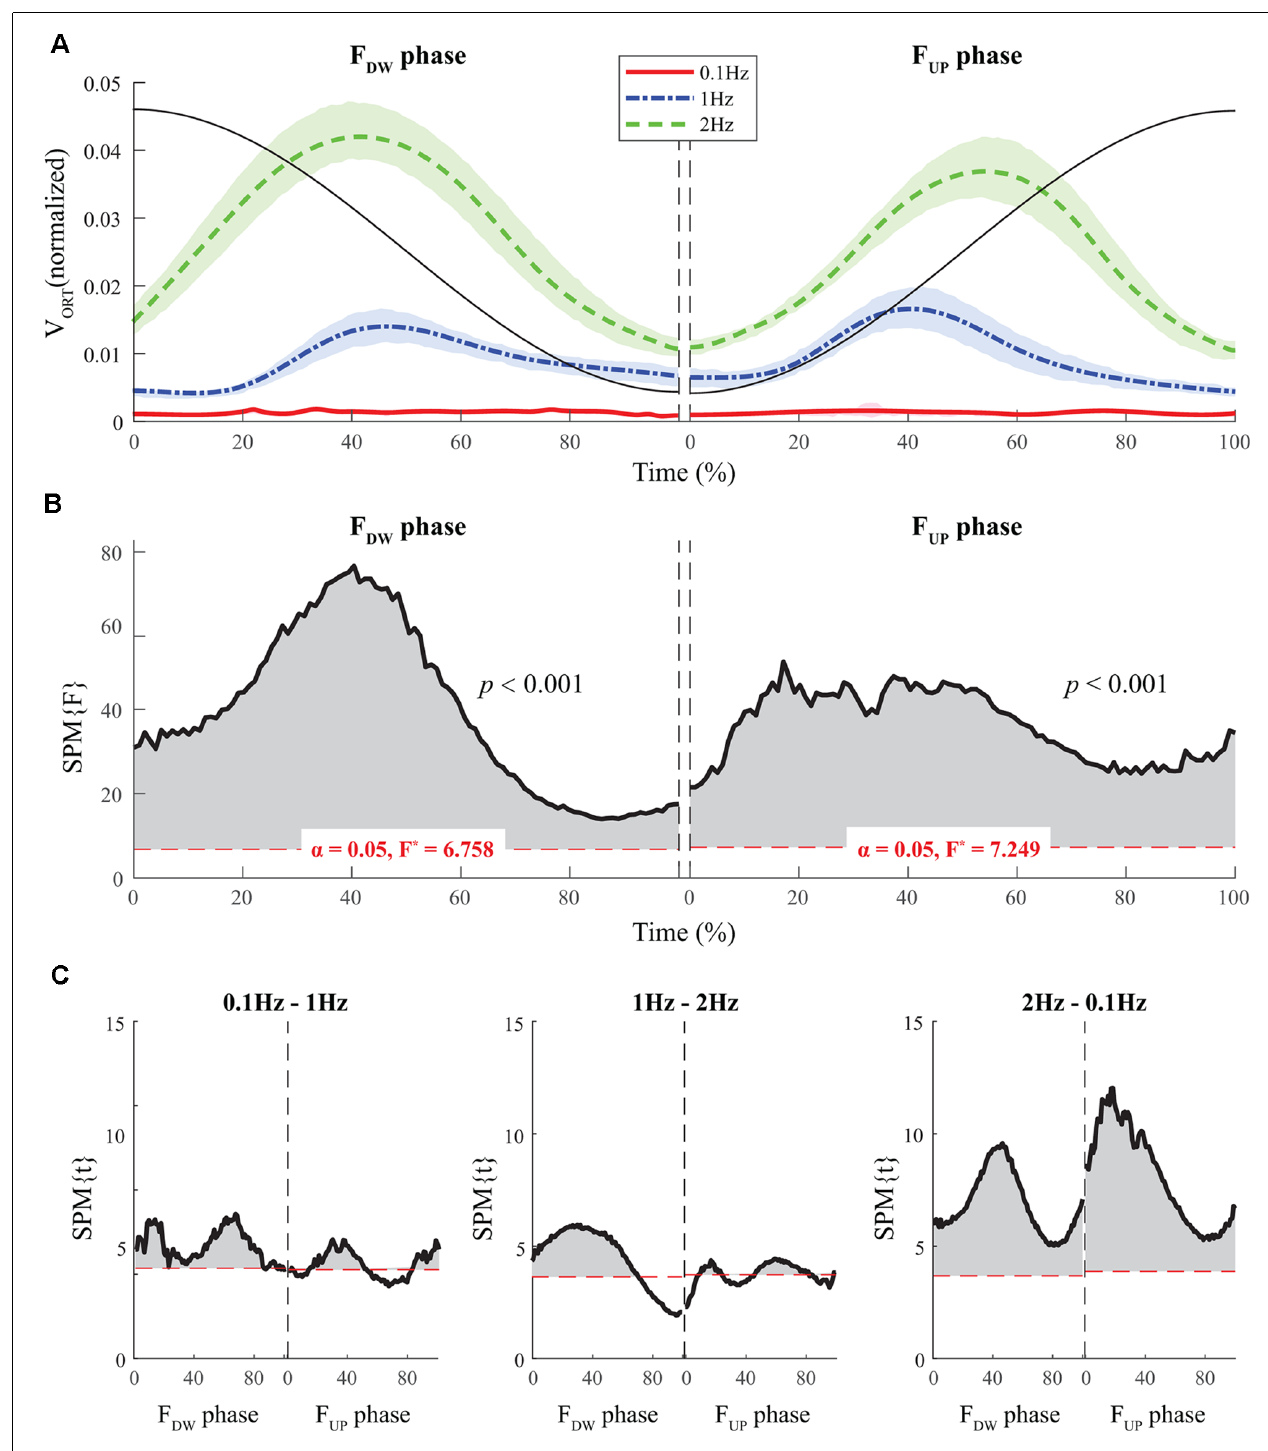
FIGURE 5 | The sample data of total force (black solid line) and the time profiles of the mean values of normalized V ORT across participants for three frequency conditions are presented with standard deviations shades during the F DW ( left panel ) and F UP ( right panel ) phases such that red solid-, blue dashed-, and green dashed-lines present ∆ V time-profiles for 0.1, 1, and 2 Hz, respectively (A) . SPM{F} trajectories on V ORT (black solid line) with repeated measures ANOVA are presented for the F DW ( left panel ) and F UP ( right panel ) phases. The horizontal dotted line in red color indicates the threshold of critical random field theory at α = 0.05 (B) . Post hoc pairwise t -tests (SPM{t}) on V ORT are presented. The horizontal dotted lines in red color indicate the threshold of critical random field theory at p < 0.05 (C)